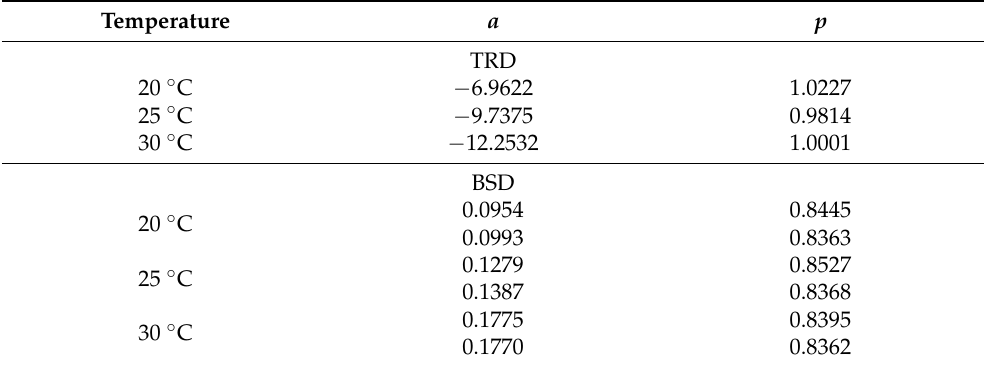
Table A1. Values of the model parameters a and p obtained by non-linear regression. In the BSD case, results are reported for two